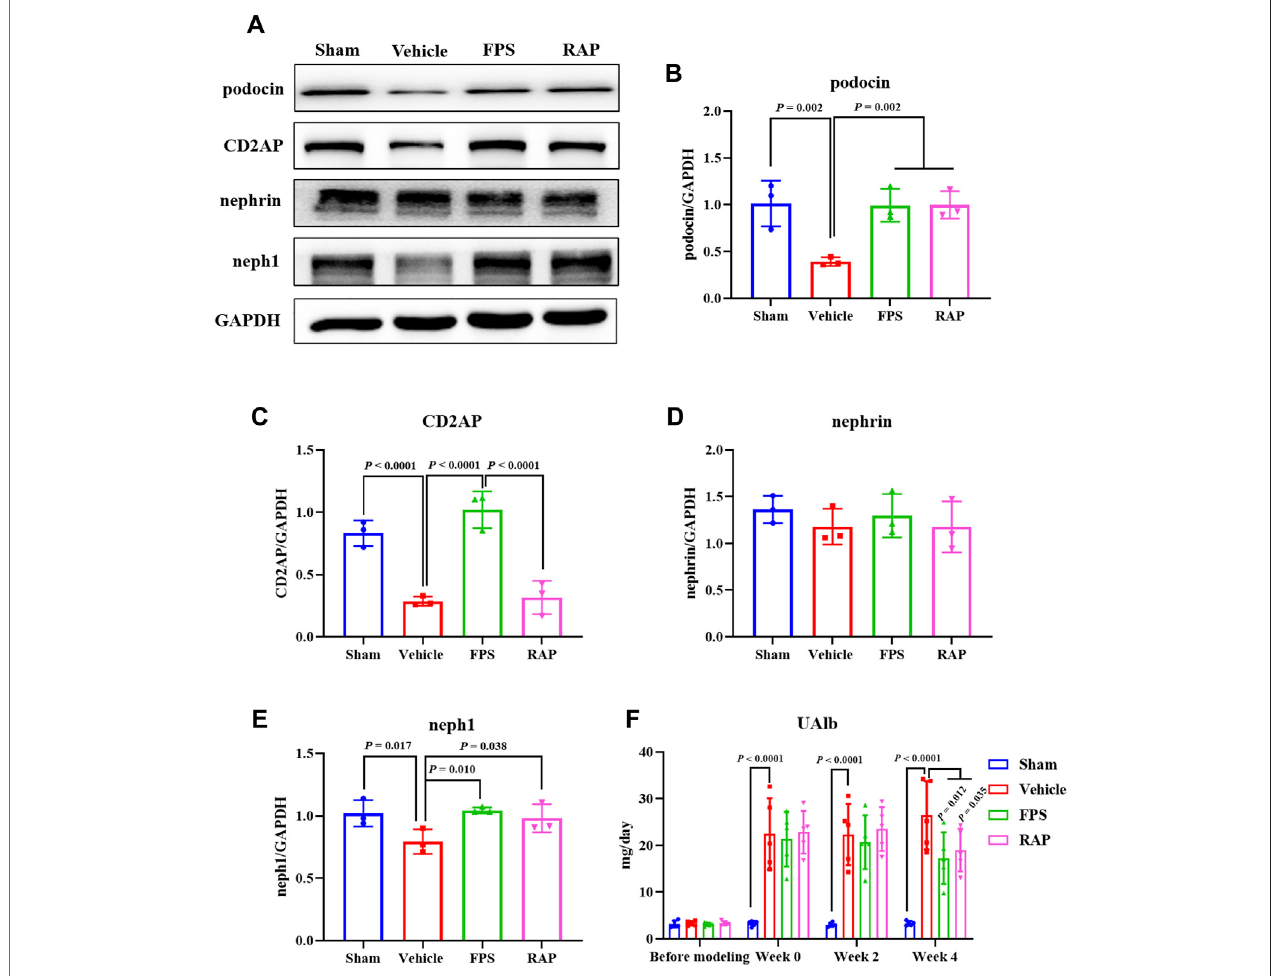
FIGURE 5 | Effects of FPS and RAP on the expression levels of podocin, CD2AP, nephrin, and neph1 in vivo , as well as UAlb in the DKD model rats. (A) The WB analysis of podocin, CD2AP, nephrin, and neph1 in the diabetic kidneys. (B – E) The rate of podocin, CD2AP, neph1, and nephrin to GAPDH, respectively. (F) The dynamic change of UAlb after drug intervention during 4 weeks. The data are expressed as the mean ± SD.